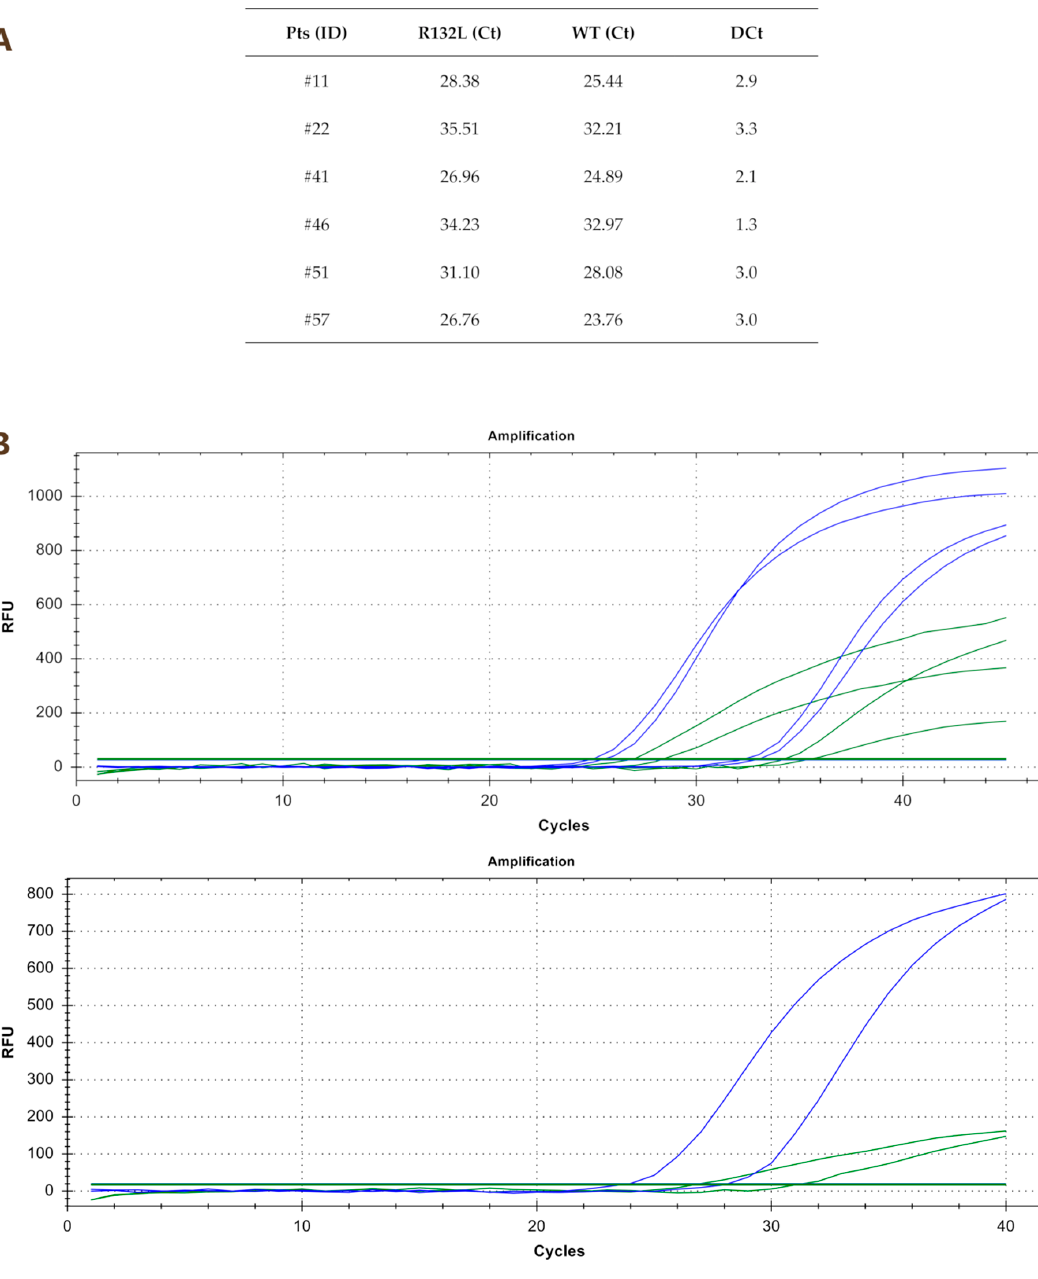
Figure 2. Ct values (panel A ) and amplification curves (panel B ) of qPCR of R132L mutated samples. RFU indicates relative fluorescent units.